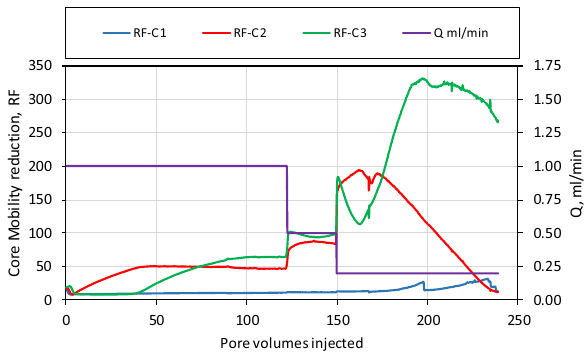
Fig. 7 Experiment 3, 1000 ppm A08 in SSW in Bentheimer. RF pm as a function of pore volumes injected. T1 = 20 °C, T2 = 60 °C and T3 = 80 °C. The volumetric injection rate is 1 ml/min ( ̇𝛾 pm ∼ 85s − 1 , ̇𝛾 ct = 165s − 1 ) from 0 to 122 pore volume, 0.5 ml/min from 122–150 PV and 0.2 ml/min from 150–239 pore